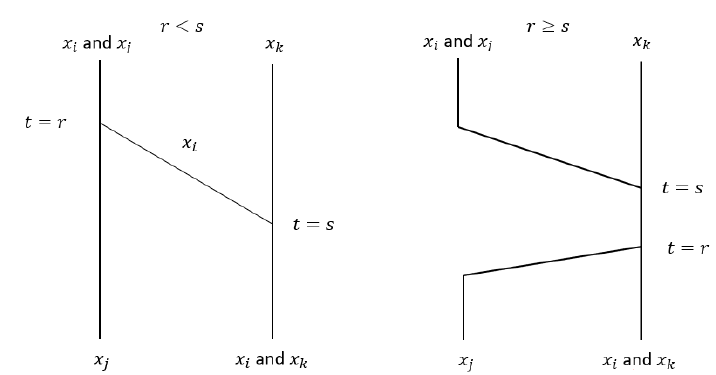
Figure 6. Illustration of proof of Theorem